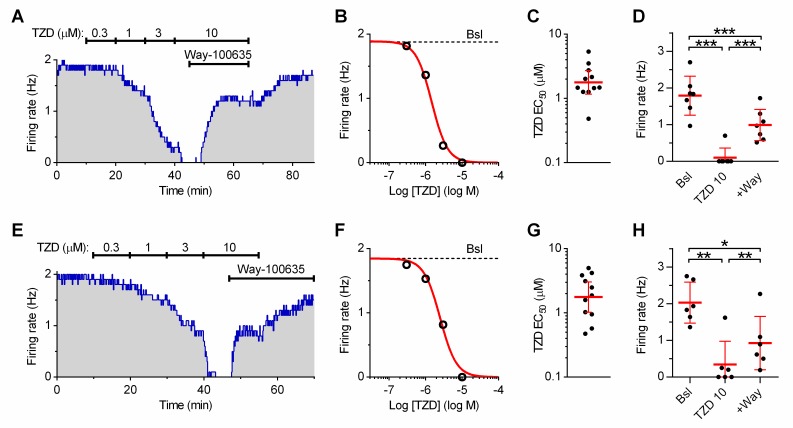
The inhibition of 5-HT neuron activity by trazodone.(A-D): Effect of trazodone (TZD) in control ACSF. (A) Representative recording illustrating the time-course of the changes in firing frequency produced by increasing concentrations of trazodone. The maximal effect was partially reversed by the selective 5-HT1A receptor antagonist Way-100635 (20 nM). (B) Dose-response curve (DRC) resulting from the experiment shown in (A). Red line is the best least-squares fit to the logistic equation. (C) Scatter plot of the individual EC50 values calculated from all experiments (n = 11). (D) Antagonism of trazodone (10 μM) effect by addition of Way-100635 (+Way; n = 7; One-way RM ANOVA: F(2,6) = 107.6; p <0.0001) in the subset of experiments in which Way was added at the end of the DRC, e.g. in (A). (E-H): Effect of trazodone in a cocktail of antagonists (see
methods). (E) Representative recording of the concentration-dependent changes in firing frequency produced by trazodone. The effect of 10 μM trazodone was partially reversed by Way-100635 (20 nM). Note the recovery of firing rate in Way-100635 after the washout of trazodone. (F) DRC resulting from the experiment shown in (E). Red line is the best least-squares fit to the logistic equation. (G) Scatter plot of the individual EC50 values calculated from all experiments (n = 11). (H) Antagonism of trazodone (10 μM) effect by Way-100635 (+Way; n = 6; One-way RM ANOVA: F(2,5) = 28.68; p <0.0014) in the subset of experiments in which Way was added at the end of the DRC, e.g. in (A). In (B) and (F), dotted line indicates the baseline (Bsl) firing rate before application of trazodone. In (C) and (G), red line and error bars indicate the geometric mean and 95% C.I. In all experiments the activity of serotonergic neurons was facilitated by the presence of 10 μM phenylephrine. * p < 0.05; ** p < 0.01; *** p < 0.001 (One-way RM ANOVA, followed by a Tukey post-hoc test).